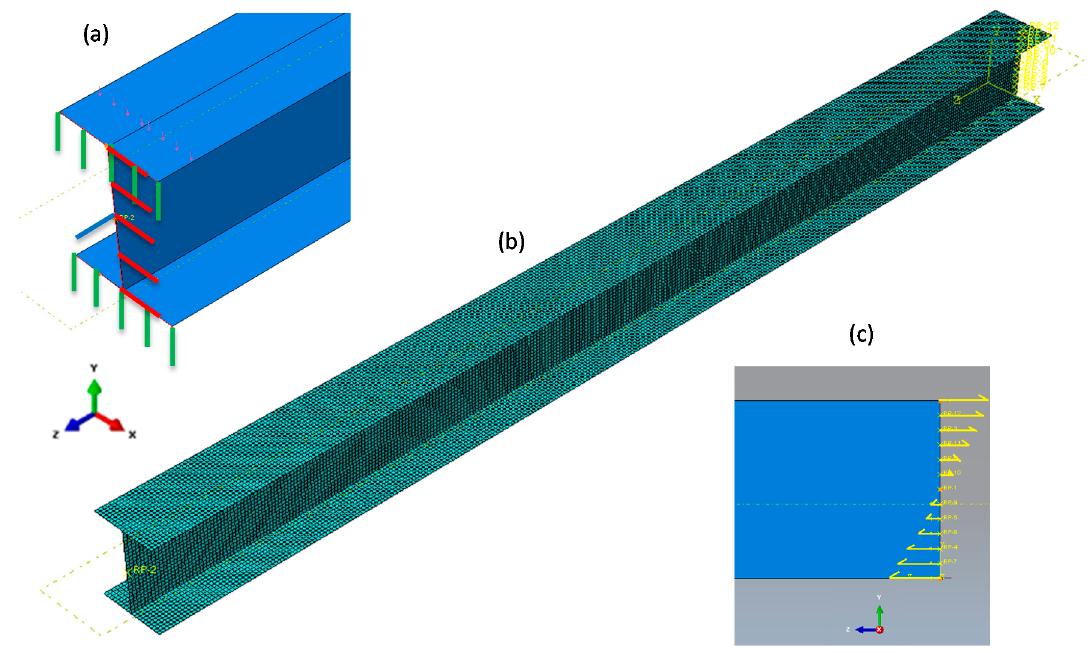
Figure 6. Finite element method (FEM) model of the I-300 × 5 × 250 × 5 beam: ( a ) boundary conditions, ( b ) division into finite elements, ( c ) method of loading with the support moment.